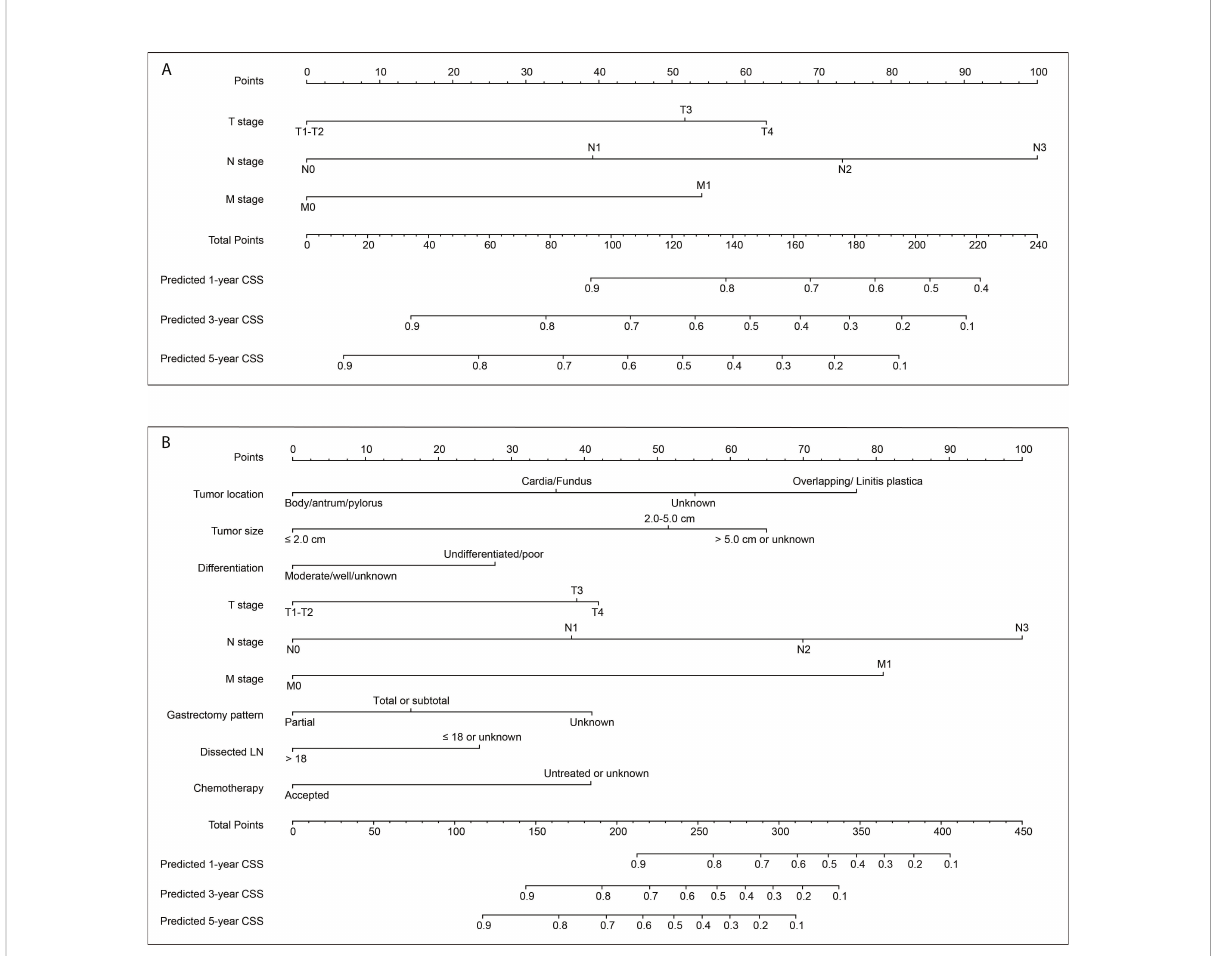
FIGURE 2 Two nomograms to predict 1-, 3 − and 5 − year cancer-speci fi c survival (CSS) rates of EOGC. (A) Model 1 nomogram was established based on tumor T stage, N stage, and M stage. (B) Model 2 nomogram was established based on tumor location, tumor size, differentiation grade, T stage, N stage, M stage, gastrectomy pattern, number of dissected lymph nodes, and postoperative